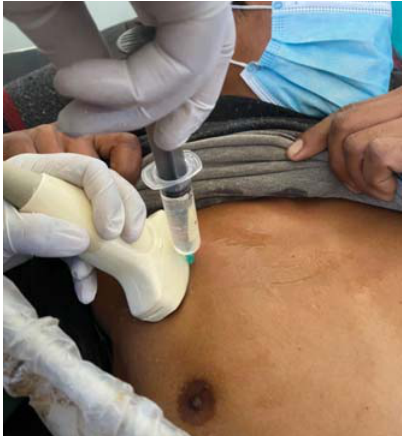
Figure 3. Bedside sonoscopic evaluation by surgeon Figure 4. Hydatid cyst